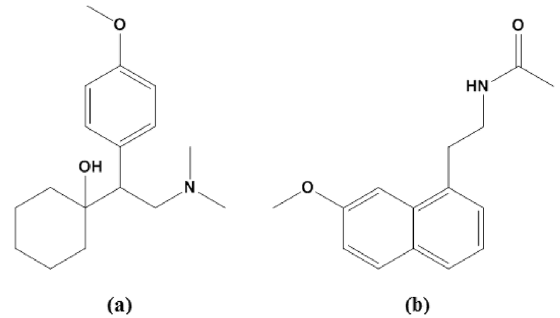
Figure 1. Structural formulae of ( a ) Venlafaxine, ( b )